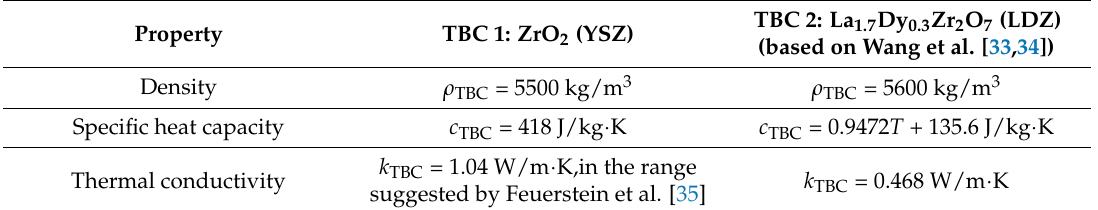
Table 1. Properties of TBC materials.